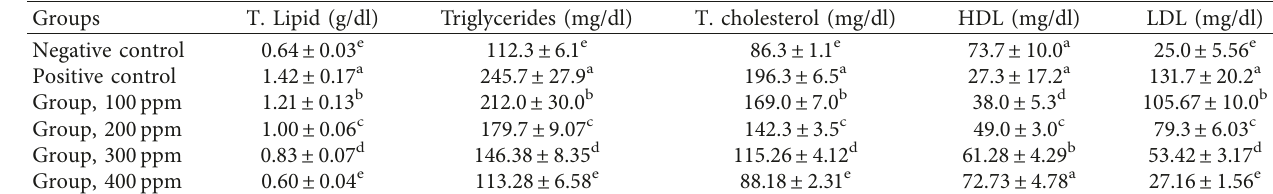
Table 4: Lipid profile.